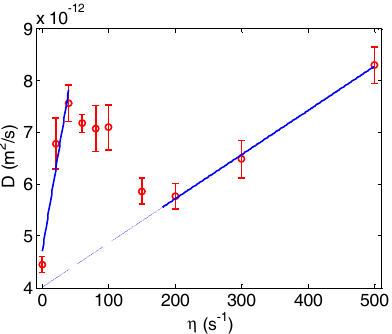
Figure 4. NP dispersion rate as a function of shear rate. Error bars indicate the standard variance for three simulations. RBCs undergo tumbling motion at a low shear rate ( η < 40 s − 1 ) and tank treading motion at a high shear rate ( η > 200 s − 1 ). In between, there is a transition region. Linear regression lines for the tumbling and tank treading regions are shown, as well.